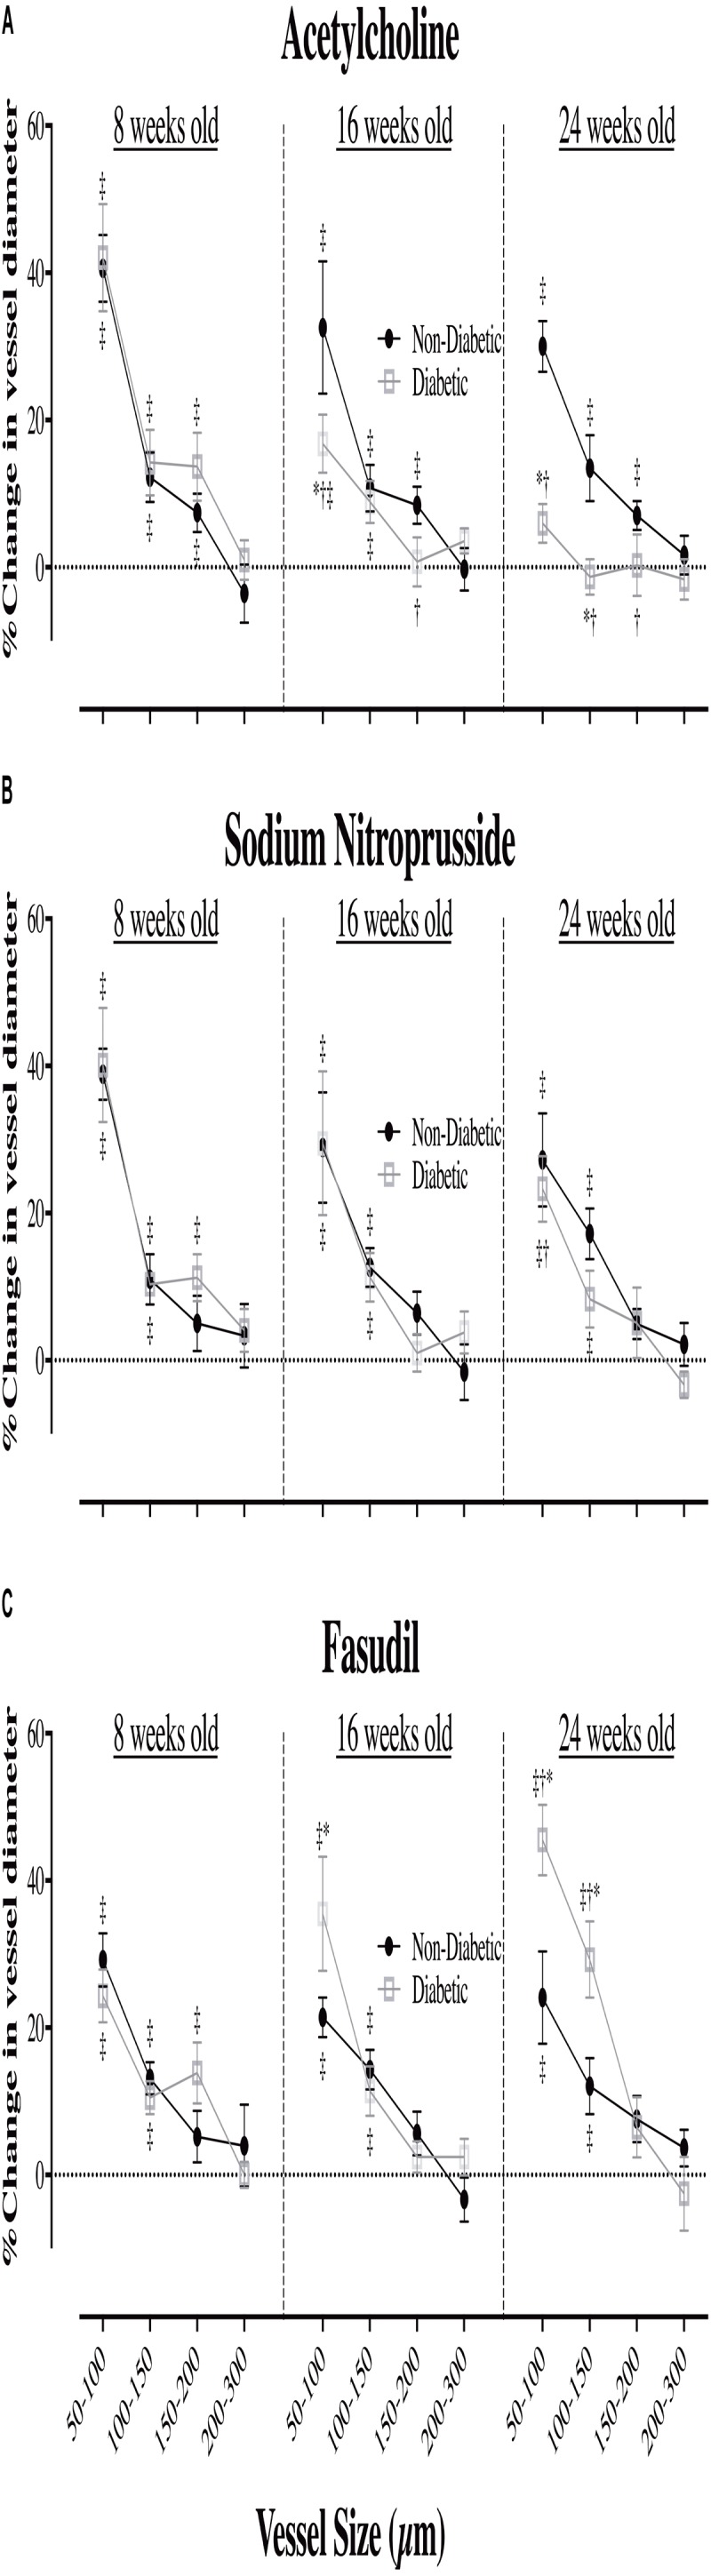
The relationship between coronary vessel size and the magnitude (%) of change in vessel internal diameter (ID) in anesthetized db/db diabetic and non-diabetic mice (mean ± SEM) at 8 weeks (n = 8 and n = 7, respectively), 16 weeks (n = 10 and n = 9, respectively), and 24 weeks of age (n = 8 and n = 7, respectively) in response to (A)
acetylcholine (ACh – 10.0 μg/kg/min for 5 min), (B)
sodium nitroprusside (SNP – 10.0 μg/kg/min for 5 min), and (C)
fasudil (20 mg/kg, i.v.). ∗Significant difference between non-diabetic vs. diabetic (P < 0.05). †Significantly different from 8-week old mice (P < 0.05). ‡Significant reduction/increase in vessel caliber, compared to baseline (P < 0.05).